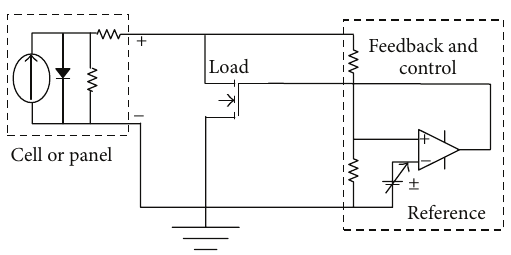
Figure 8: The proposed electronic load.